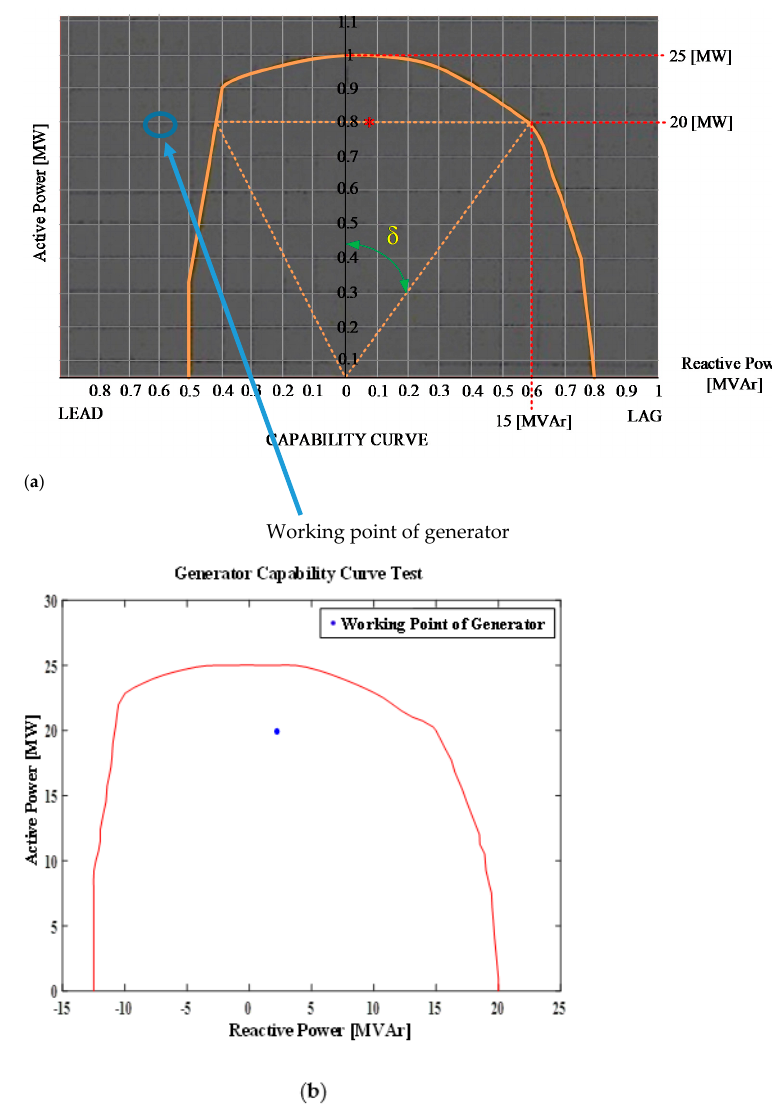
Figure 17. Comparison of the generator capability curves for the second testing: ( a ) original capability curve, ( b ) simulation results.